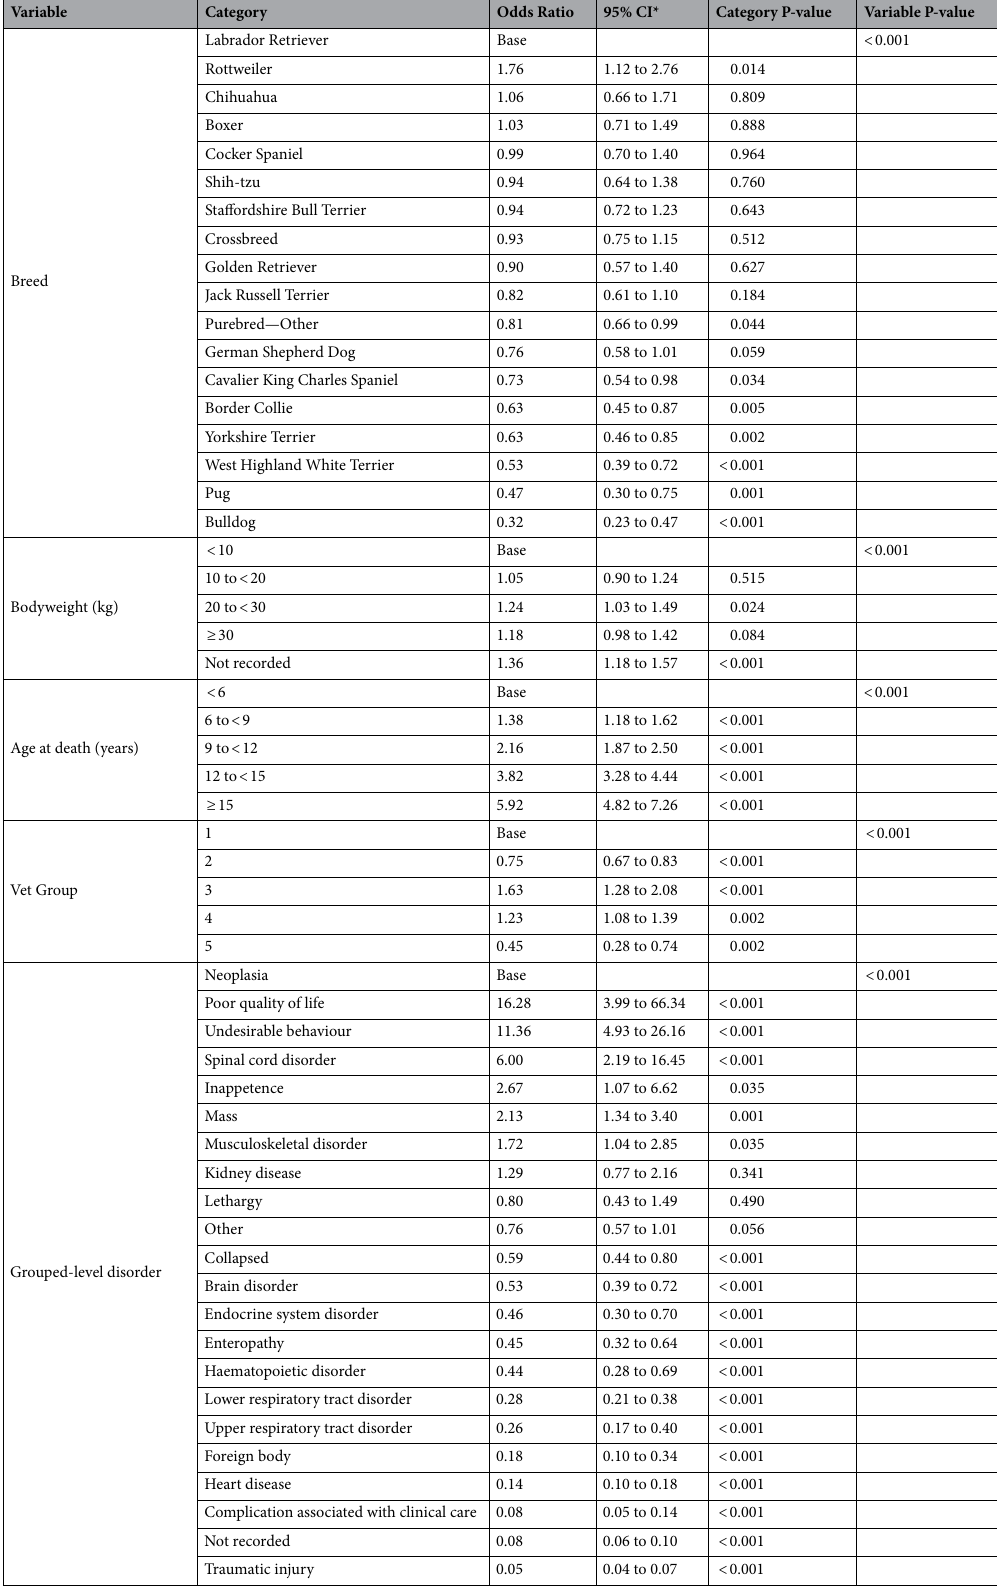
Table 2. Final multivariable model for risk factors associated with euthanasia in dogs under primary veterinary care in the UK during 2016 (n = 29,163). *Confidence